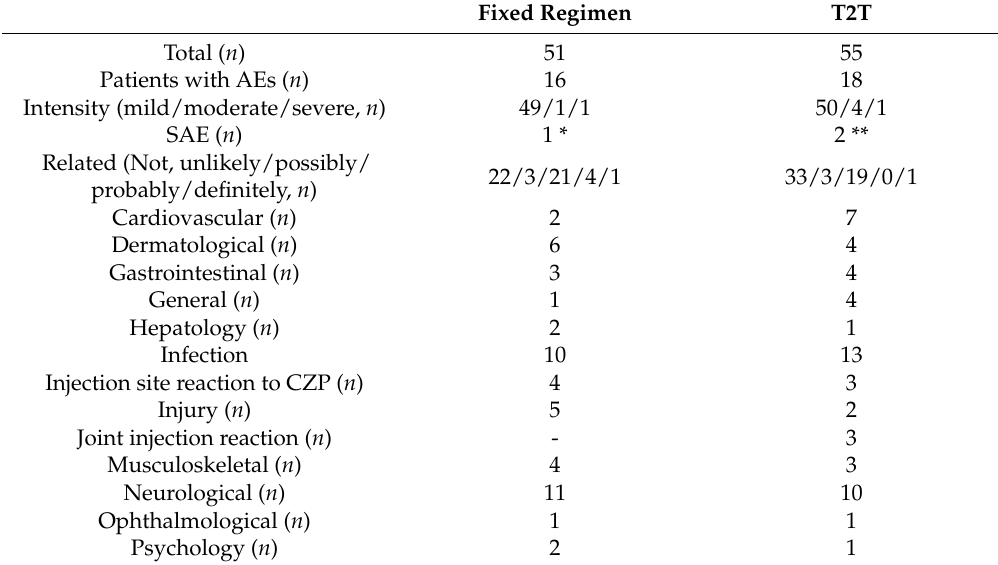
Table 3. Adverse